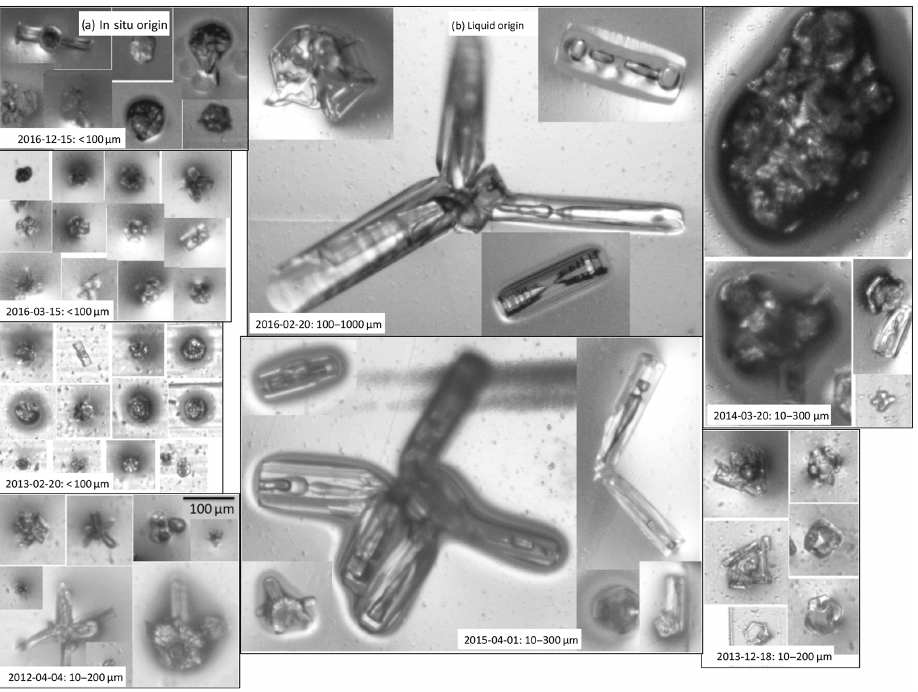
Figure 6. Some pictures of ice particles from all measurement days. The left panel shows ice particles from in situ origin cirrus, on the right liquid origin crystals are displayed. For a better understanding of the size, a 100µm bar is displayed (4 April 2012 bottom). All images have the same scale resolution and 100µm corresponds to 61